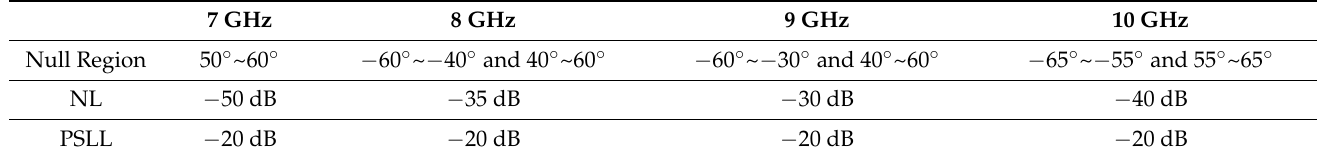
Table 8. The parameters’ settings of wide-nulling at 7 GHz, 8 GHz, 9 GHz and 10 GHz, respectively.